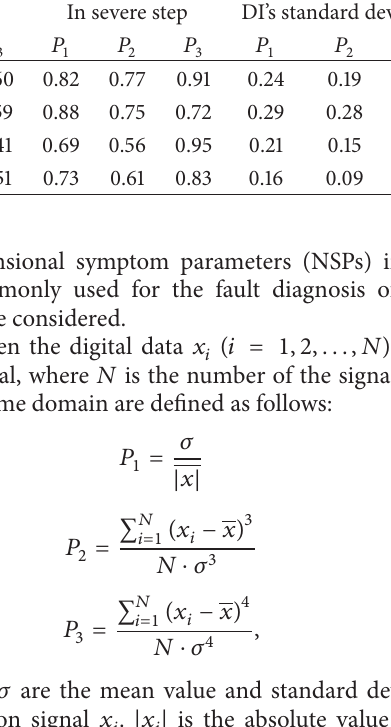
Table 2: DI values and standard deviation of DI values of 3 NSPs between two states from original signals. In mild step Two states